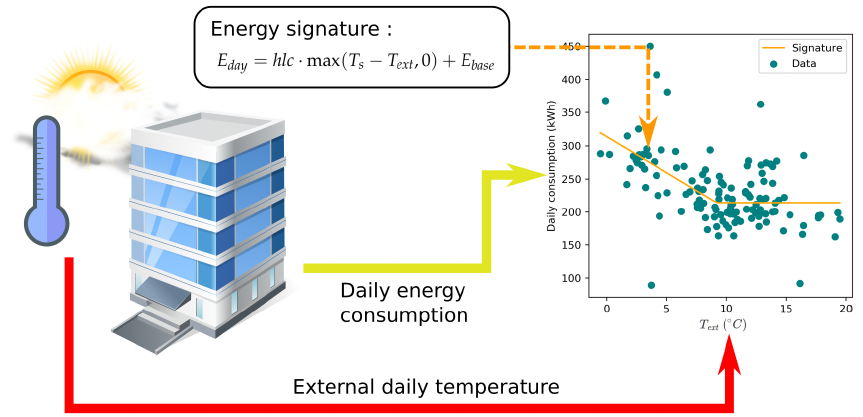
Figure 2. The energy signature